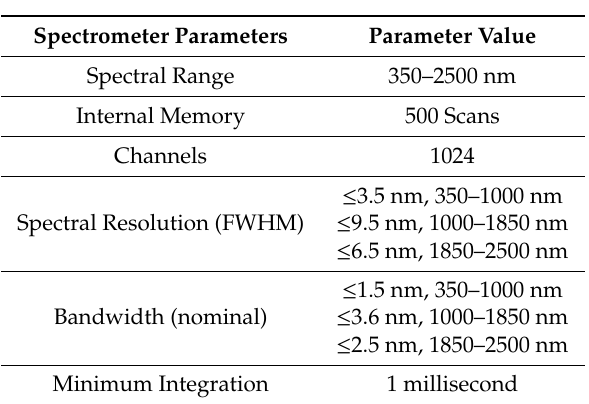
Table 1. Parameters of SVC